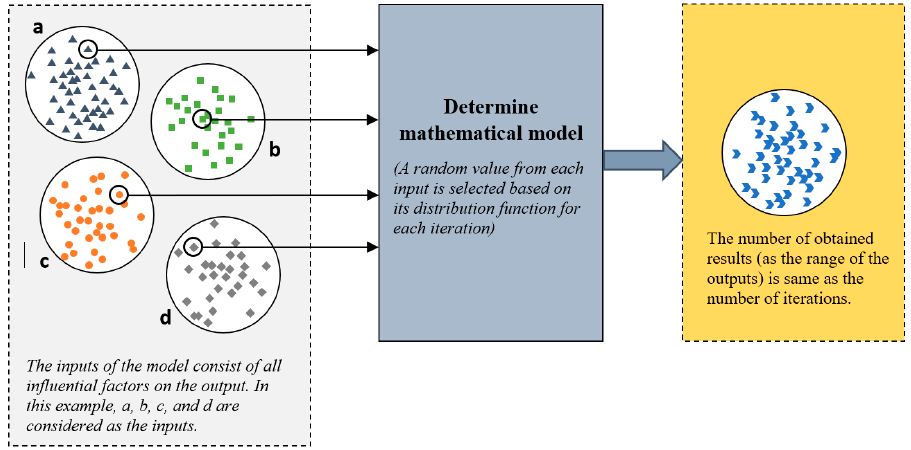
Figure 5. Operating principle of a Monte Carlo (MC) simulation [93].